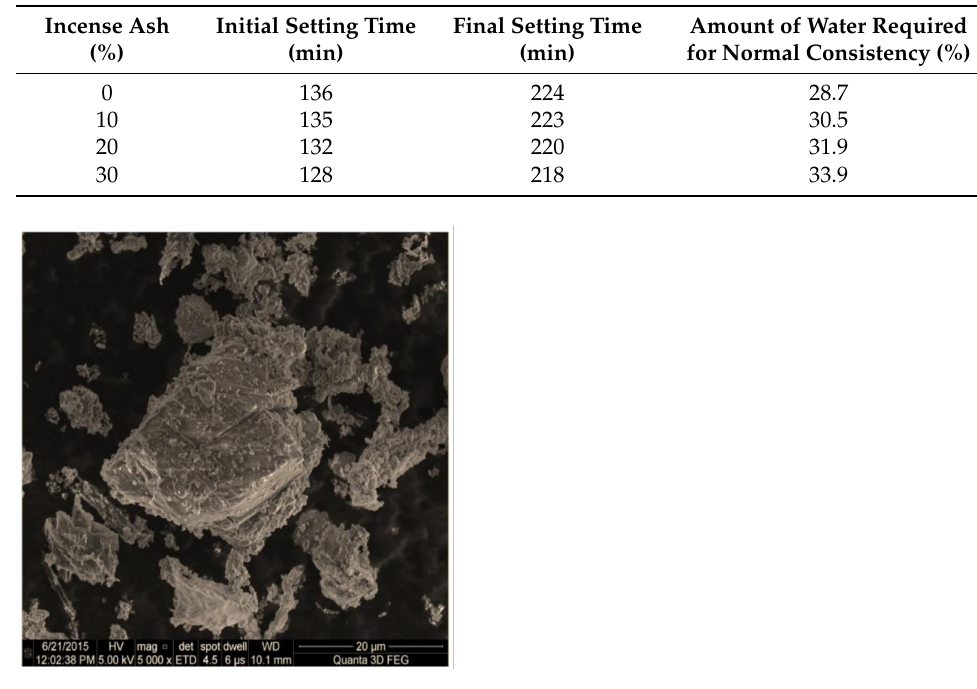
Figure 1. SEM analysis of incense ash ( ×